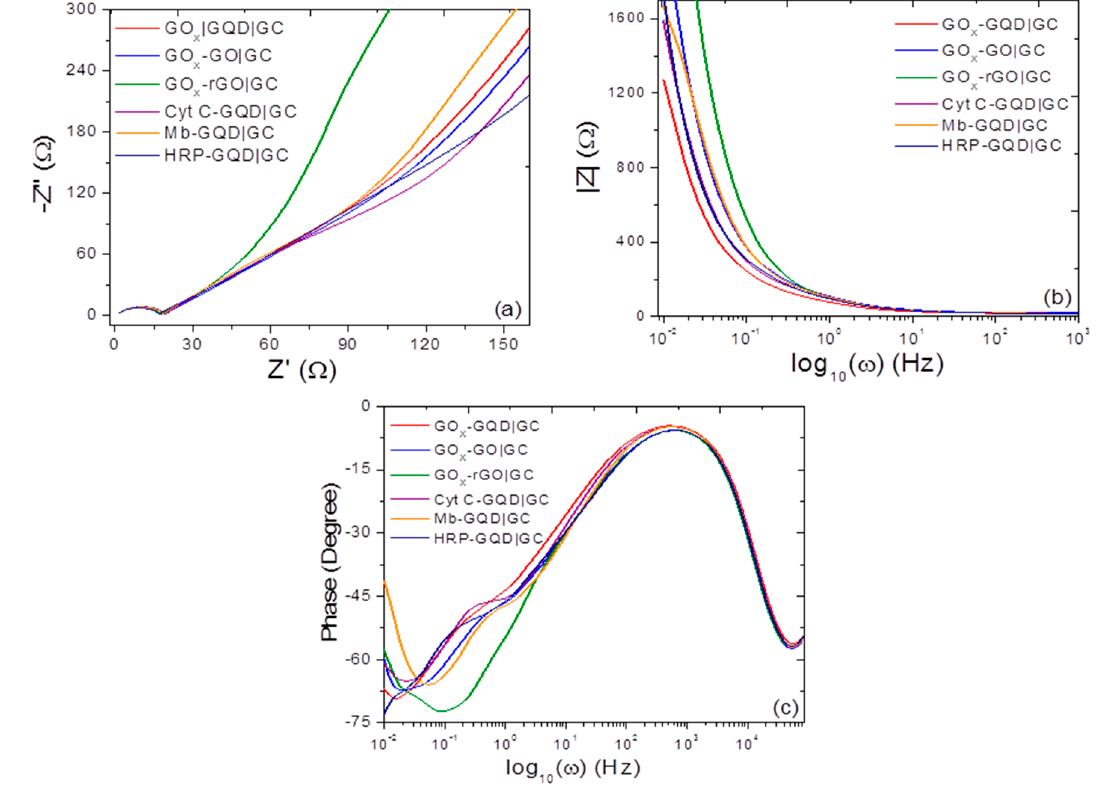
Figure 4. Electrochemical impedance spectroscopy (EIS) spectra of ( a ) Nyquist plot ( − Z” versus Z’); ( b ) magnitude of Z versus log of frequency; and ( c ) phase behavior for GO x adsorbed on GQD|GC, GO|GC, rGO|GC, native cytochrome (Cyt c ) adsorbed on rGO|GC, native myoglobin (Mb) and HRP adsorbed on GQD|GC.